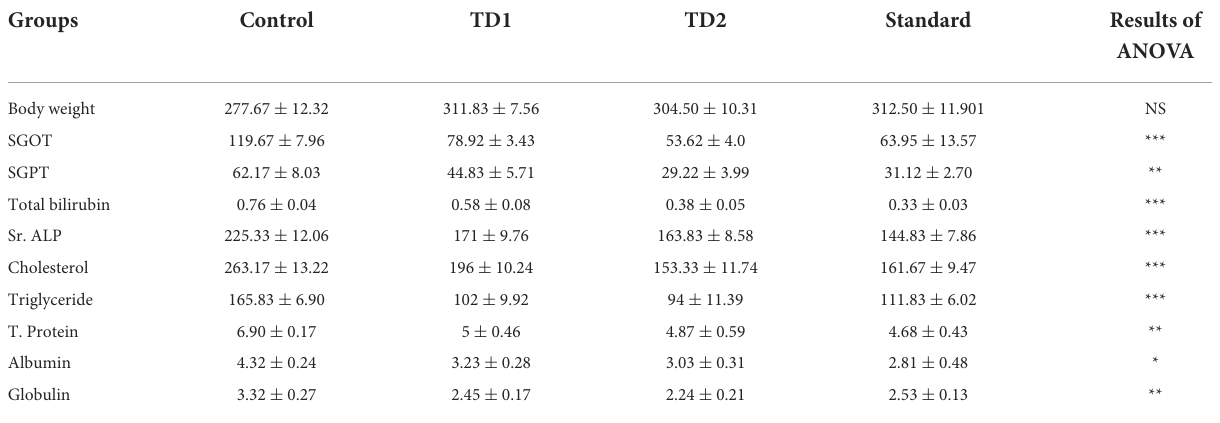
TABLE 8 Comparative biochemical data of all groups (ANOVA